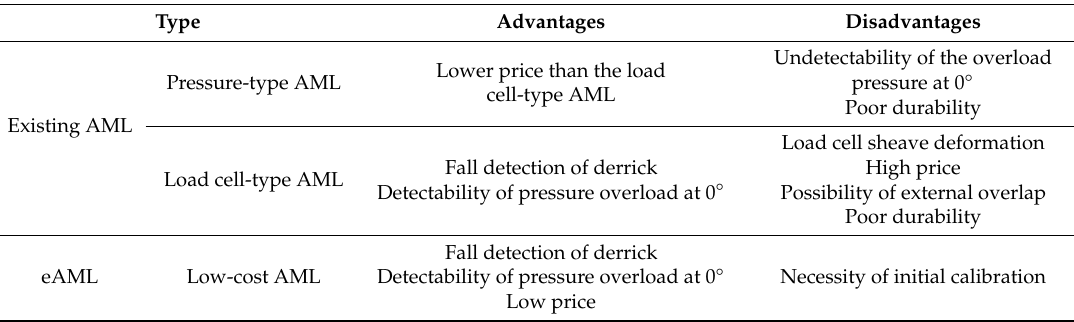
Table 1. Comparison of the existing AML and economical auto moment limiter (eAML)